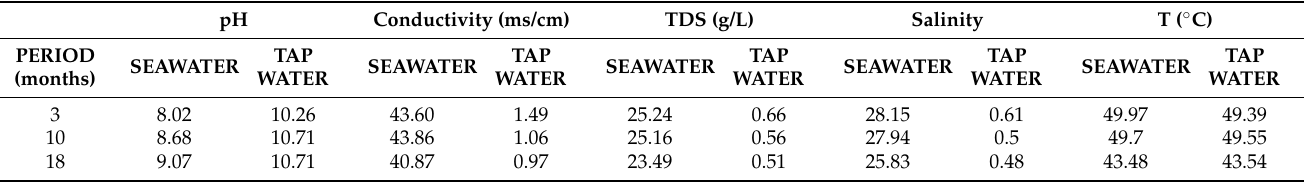
Table 2. Average values of the measured parameters (pH, conductivity, TDS, salinity and temperature) of the experiment. pH Conductivity (ms/cm) TDS